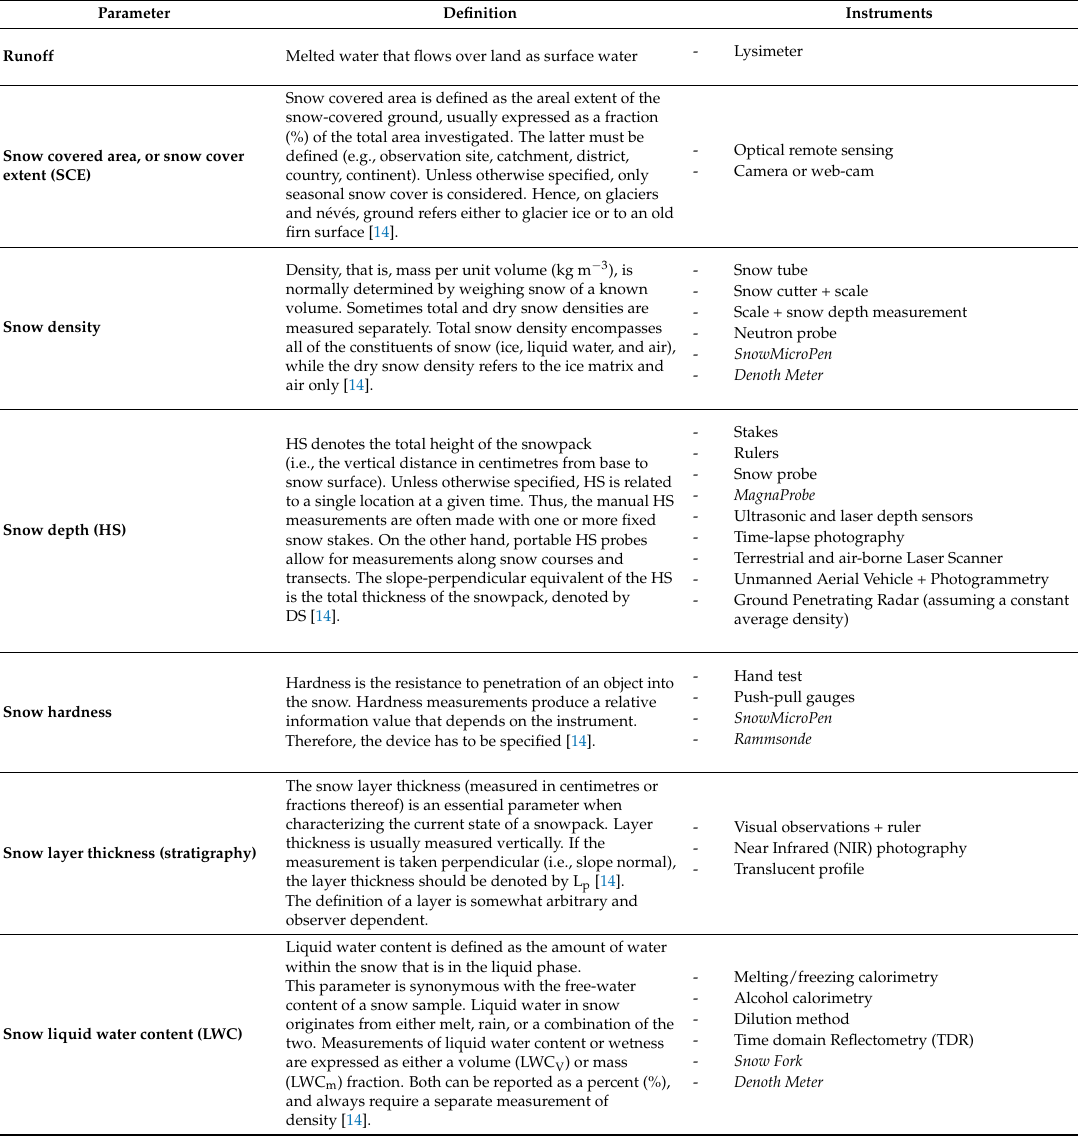
(Table A2), snow electromagnetic properties (Table A3), precipitating and suspended snow (Table A4), and snow composition (Table A5). Table A1. List of measurable snow macrophysical properties: name of the properties (first column), definition (second column), and applicable